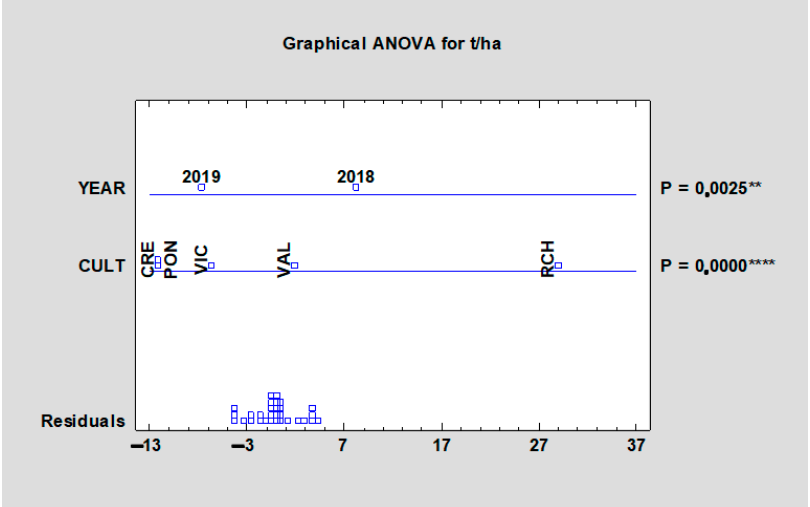
Figure 1. Effect of the experimental year and cultivar on the mean juice yield of all rhubarb cultivars. Abbreviations: PON, ´Poncho´; CRE, ´Canadian Red´; VAL, ´Valentine´; RCH, ´Red Champagne´; VIC, ´Victoria´. LSD test with significance: significant at p ≤ 0.01 (**), or p = 0.0000 (****).